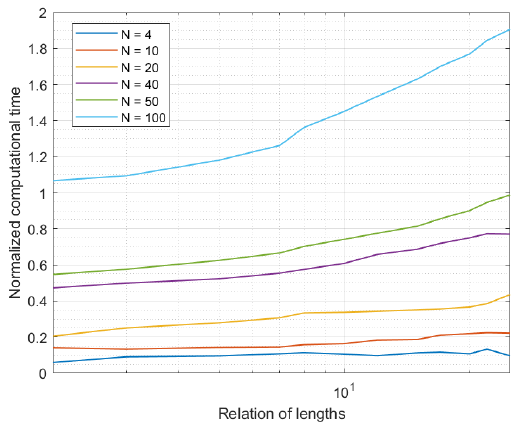
Figure 4. Results of the second experiment.